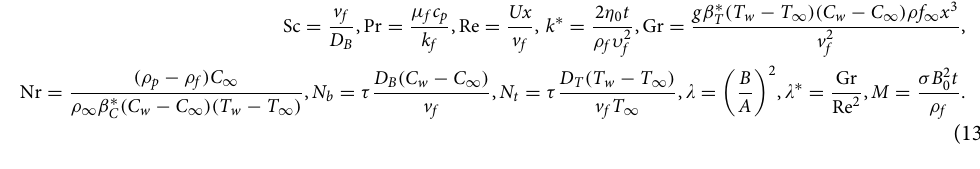
Here the Schmidt number, Prandtl number, Reynolds number, Couple stress parameter, Biot number, Gra- shof number, Buoyancy ratio, Brownian motion and thermophoresis parameters, the rotation parameter, mixed convection parameter, and magnetic field parameter are